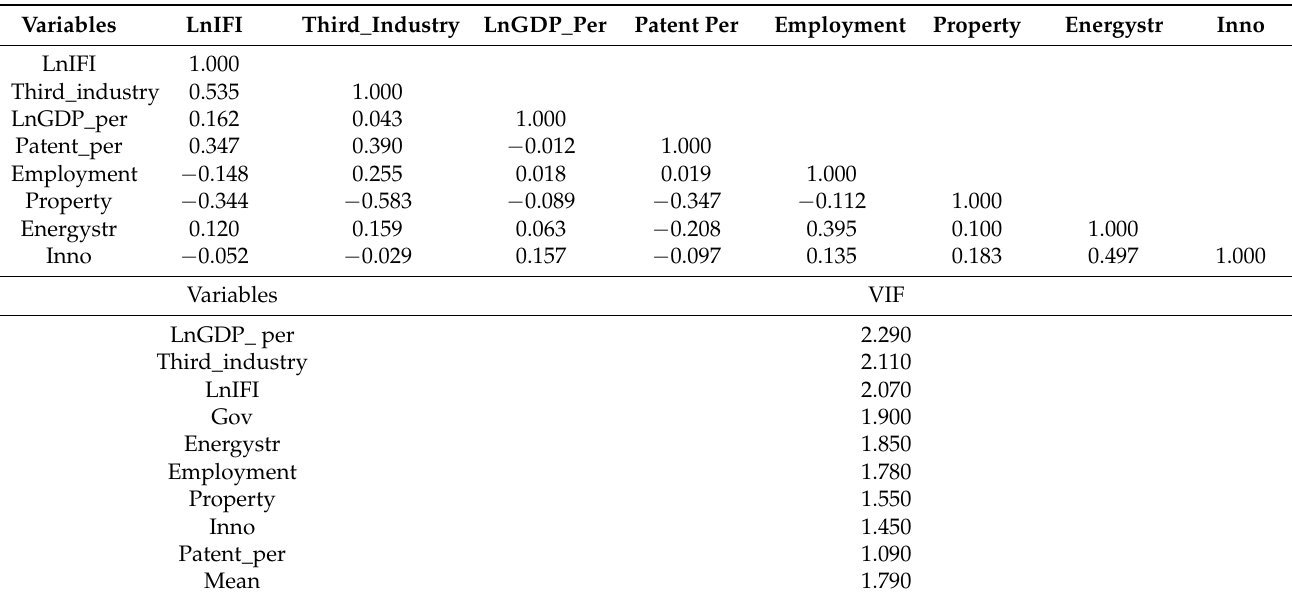
Table 5. Matrix of correlations.